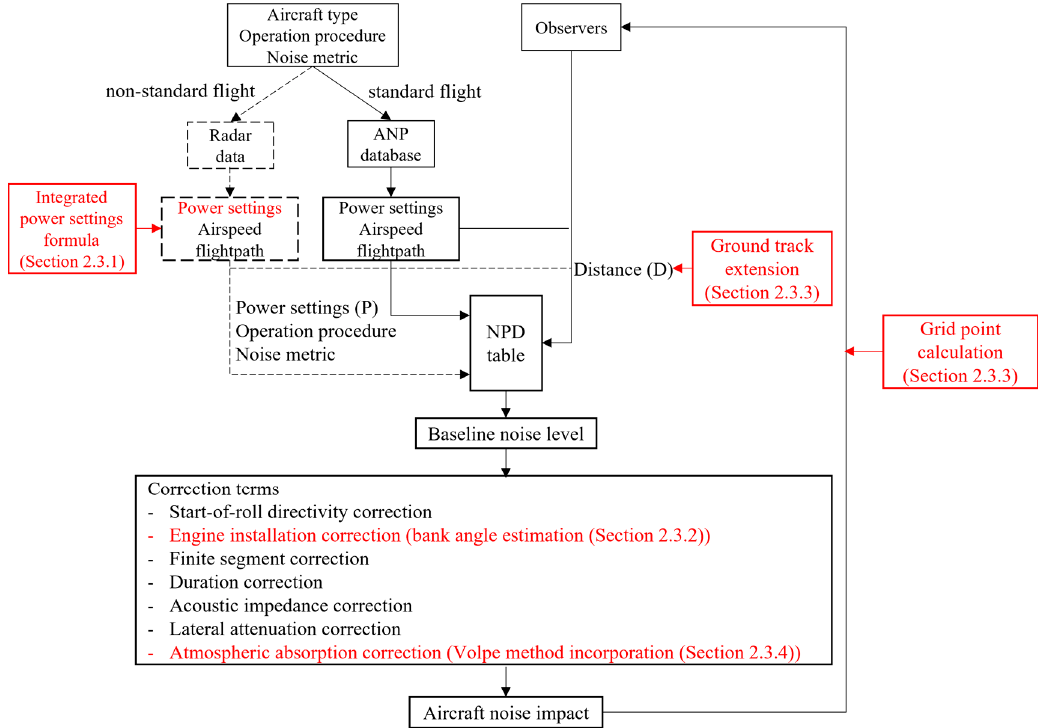
Figure 1. Aircraft noise prediction methodology, as built-up from the baseline approach [49] (in black) whereas incorporating specific addendums (in red).